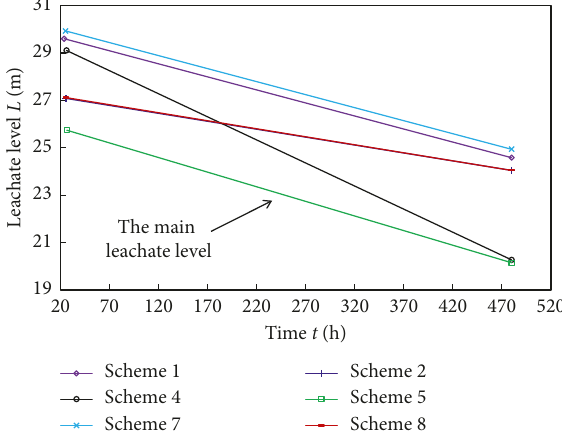
Figure 20: Leachate level distributions of several schemes ( t � 25 − 480h).